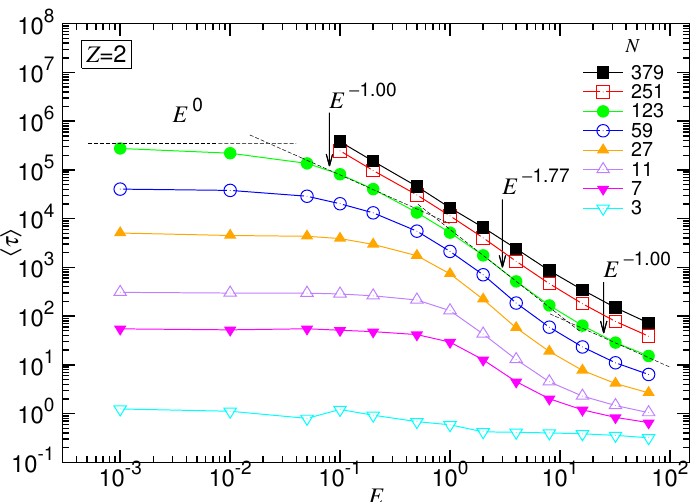
Figure 8. Mean translocation time (cid:104) τ (cid:105) as a function of the driving field E in the divalent salt solution. The value of N can be read in the legend. The dashed lines indicate the four scaling behaviors for N = 123.